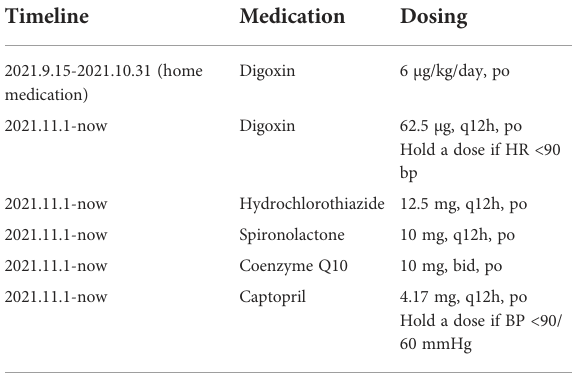
TABLE 1 Medications for heart failure.